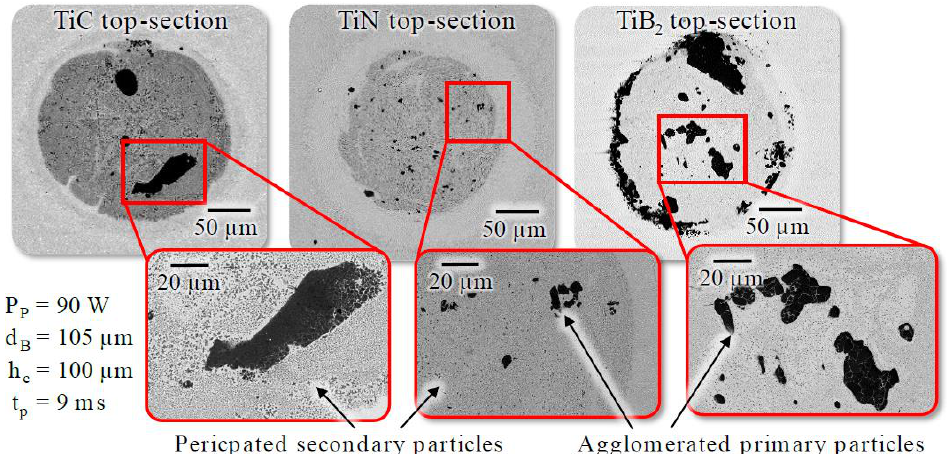
Figure 10. ( a ) Backscattered electron microscopy (SEM-BSE) image of the precipitated top-section and corresponding detail view.